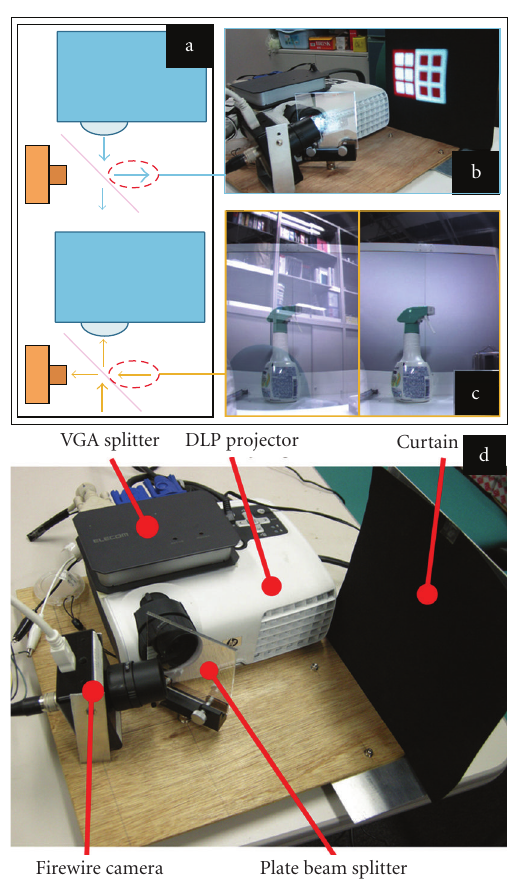
Figure 7: (a) The concept of pro-cam coaxialization using a beam splitter. (b) The use of a curtain to block projector’s reflected light. (c) Captured image without and with the curtain (left and right). (d) Our beam splitter